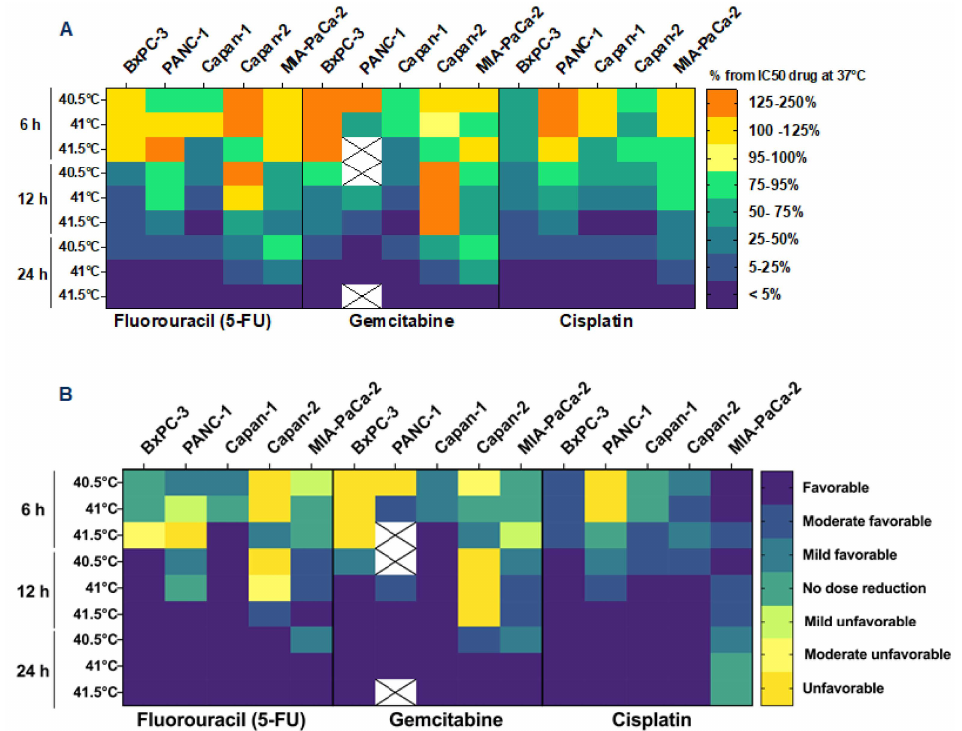
Figure 5. Hyperthermia enhances the cytotoxic effect of chemotherapeutic agents. Heatmap dis- playing the IC 50,ratio, drug which represent the combined effect of hyperthermia and chemotherapy compared to single therapy (drug administered at 37 ◦ C). Data are expressed as a percentage of IC 50,drug at 37 ◦ C experimental conditions. X indicates data not available ( A ). Dose reduction index values are plotted in ( B ) to further confirm the results expressed as relative IC 50,ratio, drug . Unfavor- able: DRI < 0.8; Moderate unfavorable: 0.8 < DRI > 0.85; Mild unfavorable: 0.85 < DRI > 0.9; No dose reduction: 0.9 < DRI > 1.1; Mild Favorable: 1.1 < DRI > 1.3; Moderate favorable 1.3 < DRI > 1.8; Favorable DRI > 1.8. X indicates data not